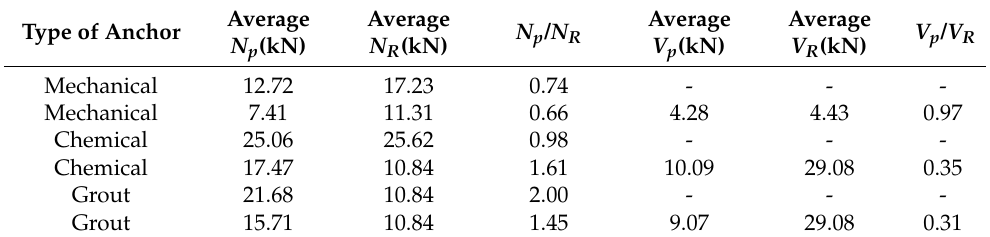
Table 9. Relationship between experimental values obtained from the pull-out tests and estimated values. Average Average Average Average V p / V R N p / N R Type of Anchor V p (kN) V R (kN) N p (kN) N R (kN) Mechanical 12.72 17.23 0.74 - - - Mechanical 7.41 11.31 0.66 4.28 4.43 0.97 Chemical 25.06 25.62 0.98 - - - Chemical 17.47 10.84 1.61 10.09 29.08 0.35 Grout 21.68 10.84 2.00 - - - Grout 15.71 10.84 1.45